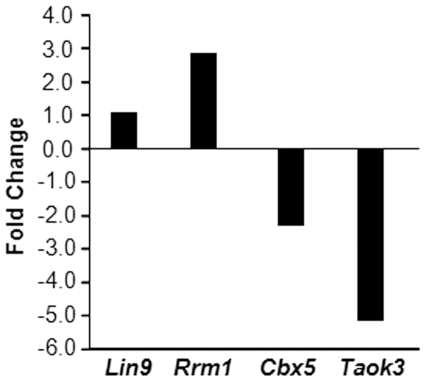
Validation of microarray analysis.Low density mononuclear cells (LDMNC) were isolated from WT and p85α−/− mice and cultured in the presence of IL-3 (10 ng/mL) for 1 week. KIT and IgE receptor double positive mast cells were sorted by using FACS. Sorted mast cells were stimulated with SCF (100 ng/mL) for 48 hours and mRNA was extracted using the RNeasy Plus Mini Kit (Qiagen, Valencia, CA). Qualitative real-time PCR was performed for the indicated genes using primers from Applied Biosystems as described in methods. Results show fold change of indicated genes, normalized to Actin, in p85α-deficient MCps compared to WT MCps.